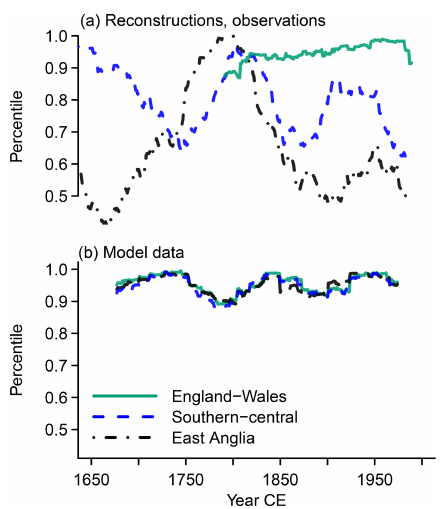
Figure 7. Visualization of how percentile values change over win- dows. We show what the percentile 93.3 MAMJJ precipitation amount for a reference window represents over time for England– Wales (green solid lines), southern–central England (blue dashed lines), and East Anglia (black dash-dotted lines) in (a) reconstruc- tions, observations, and (b) simulations. The reference window is centered on